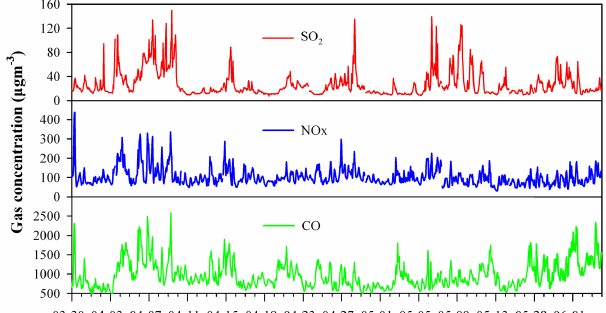
Fig. 2. Time-series of the hourly gaseous concentrations of SO 2 , NO x and CO, all units are in µgm − 3